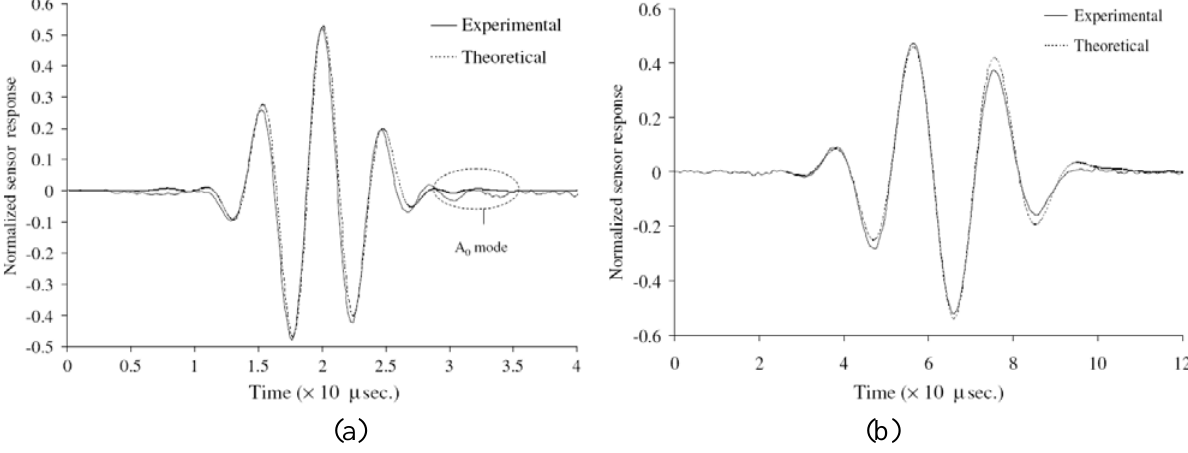
Figure 11. Comparison between the normalized sensor signals obtained analytically and mode at central frequency of 200 kHz experimentally for the circular actuator: (a) the S 0 mode at central frequency of 50 kHz. Taken from Raghavan and Cesnik and (b) the A 0 [42].